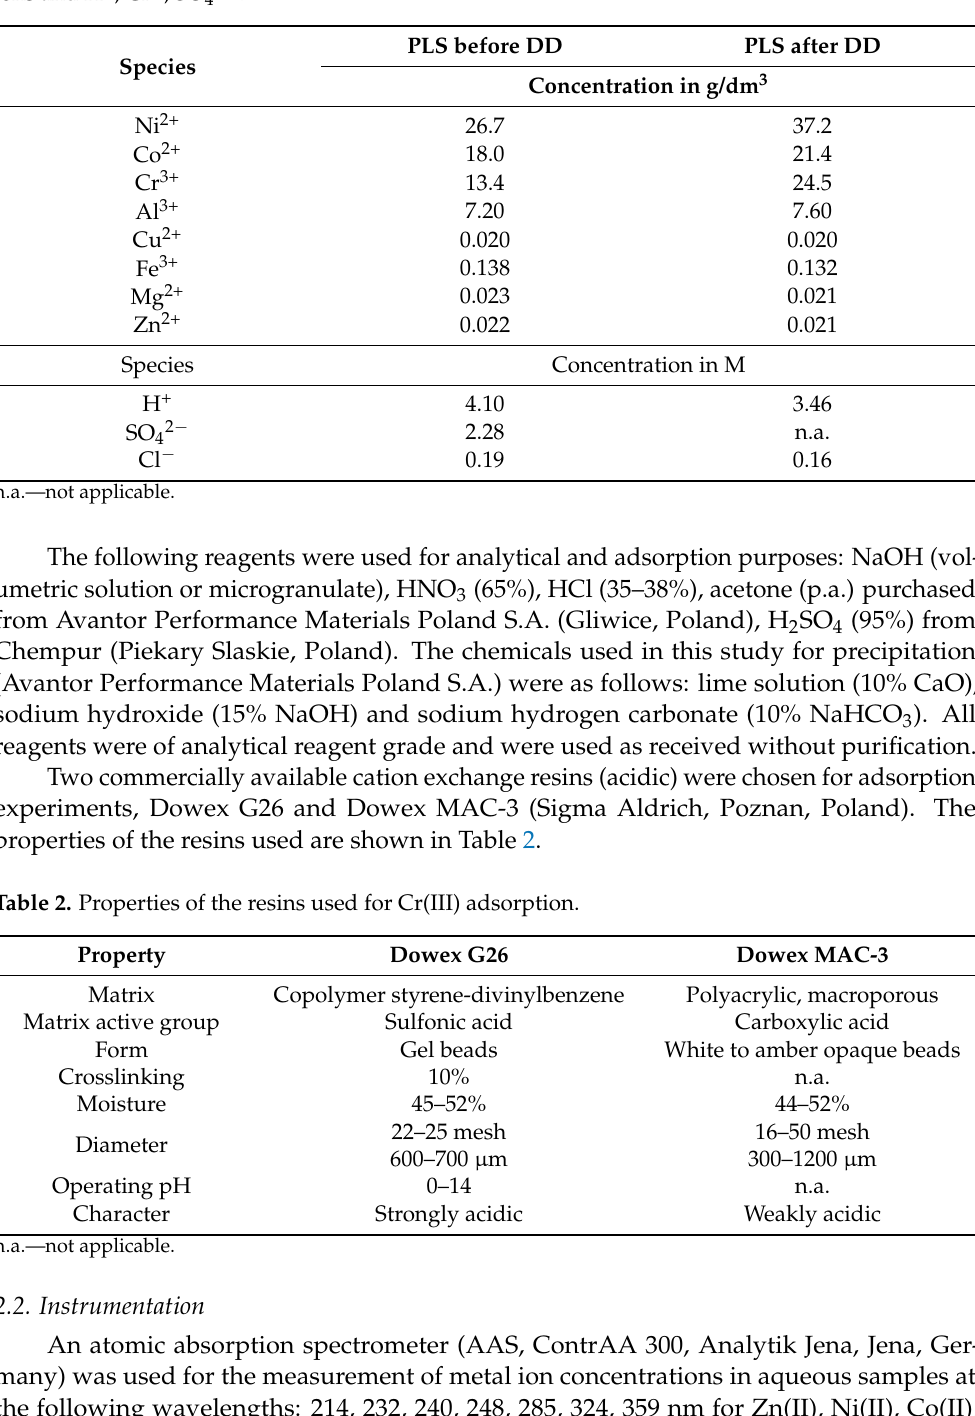
Table 1. Composition of the PLS sulfate solution before and after DD: average concentration of metal ions and H + , Cl − , SO 42 − .